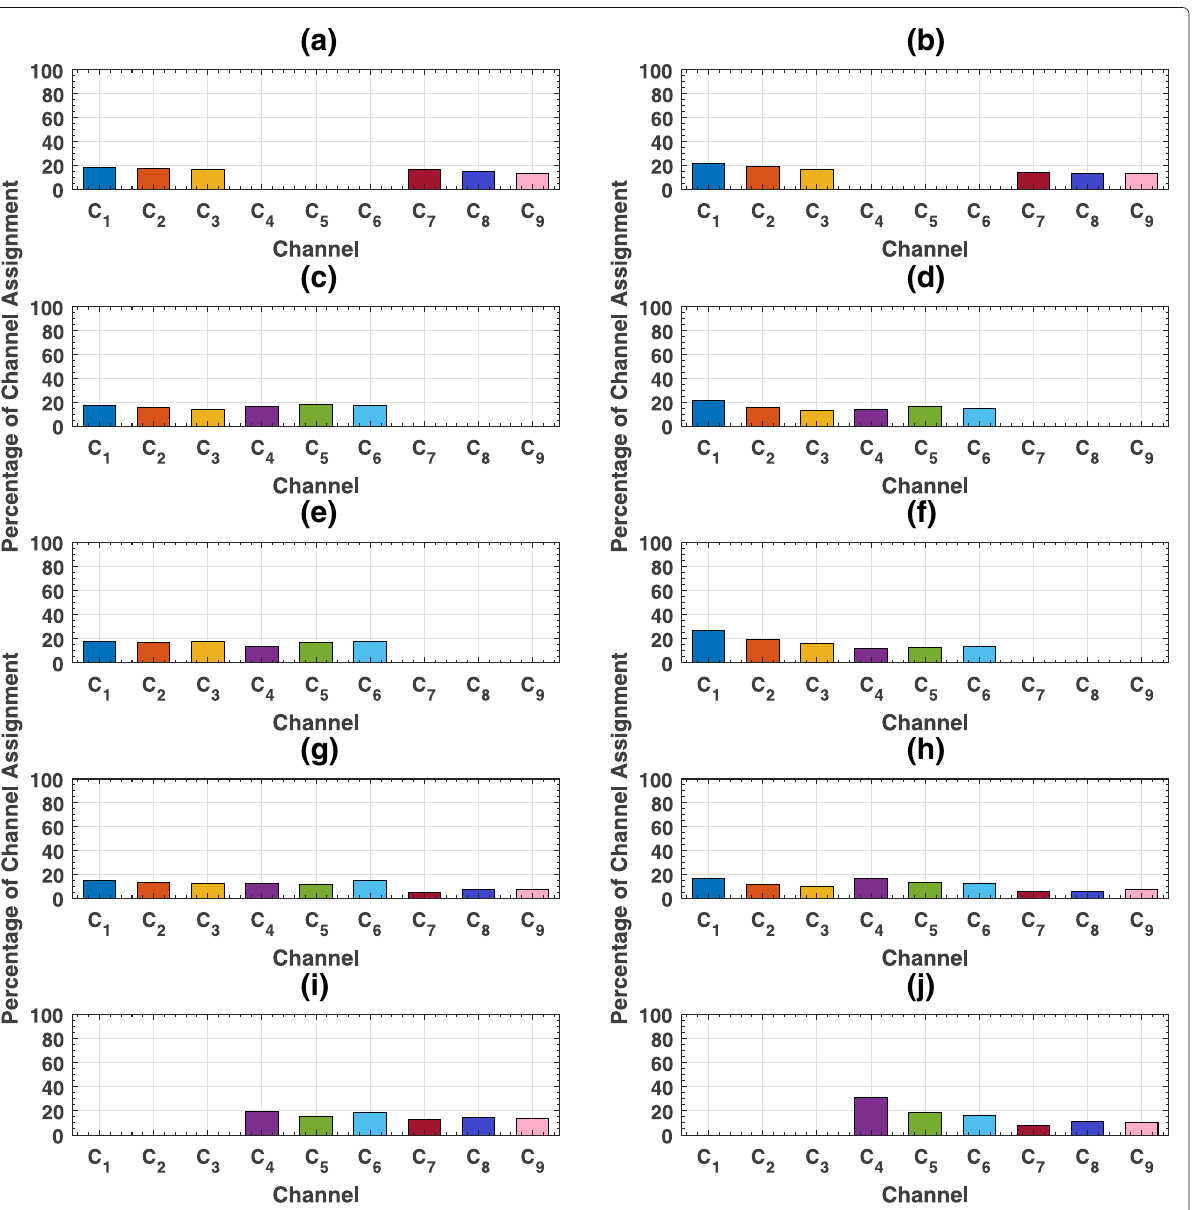
Fig. 9 Percentage of channel assignment—Scenario 1. a U 3 (U-SM). b U 3 (BS-SM). c U 4 (U-SM). d U 4 (BS-SM). e U 5 (U-SM). f U 5 (BS-SM). g U 6 (U-SM). h